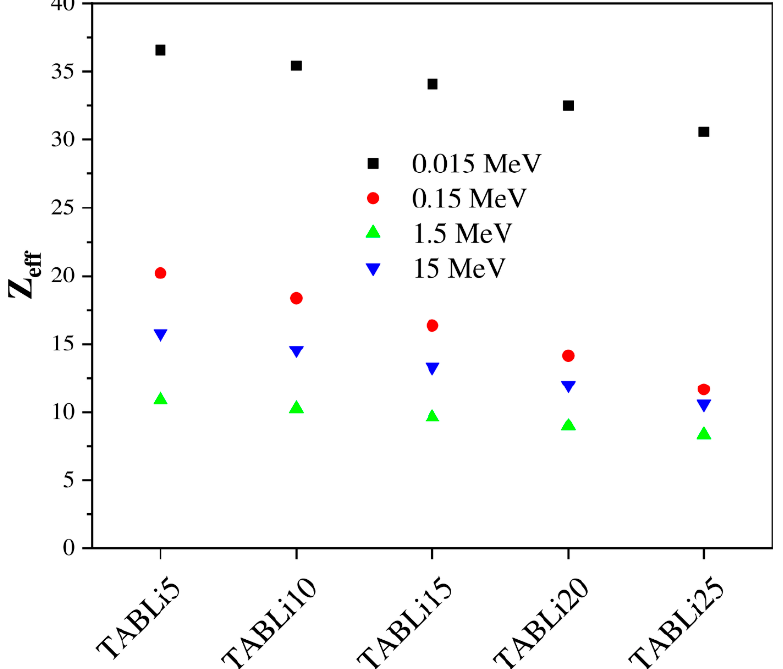
Figure 14. The dependence of the studied glasses’ effective atomic number (Z eff ) on the LiO 2 concen- tration.